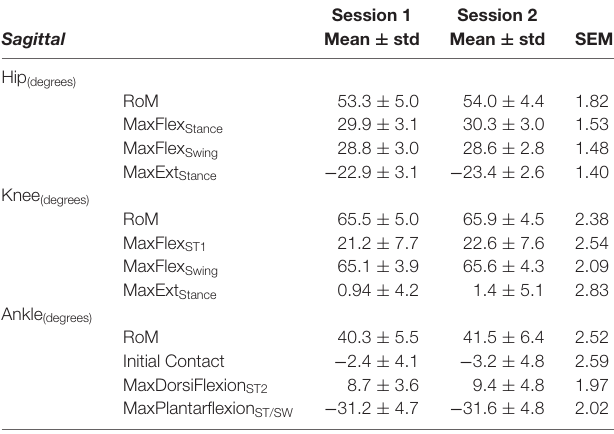
TABLE 6 | Sagittal plane variables—Fastest Comfortable Walking Speed: mean ± standard deviation (std) for Session 1 and Session 2, and Standard Error of Measurement (SEM).